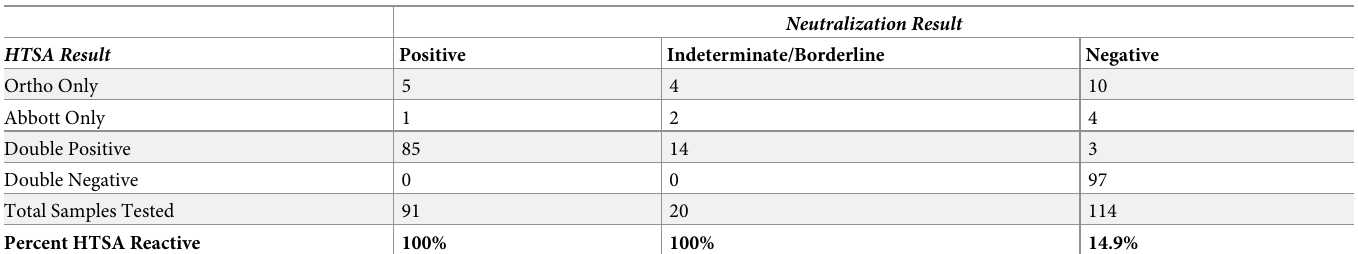
Table 3. Neutralization activity as a function of serological